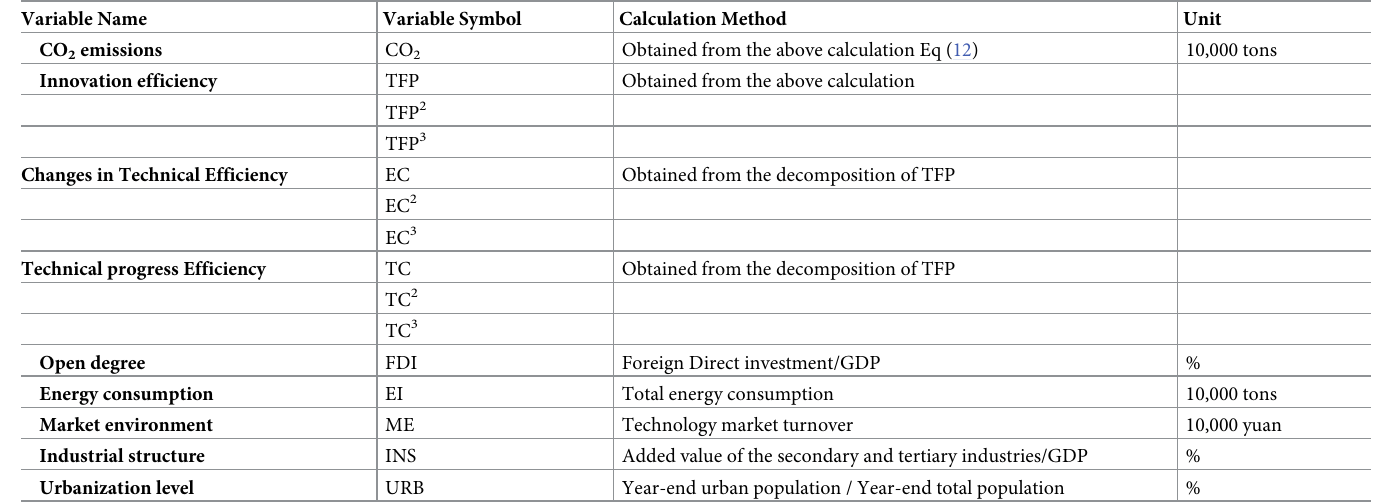
Table 2. Calculation method.